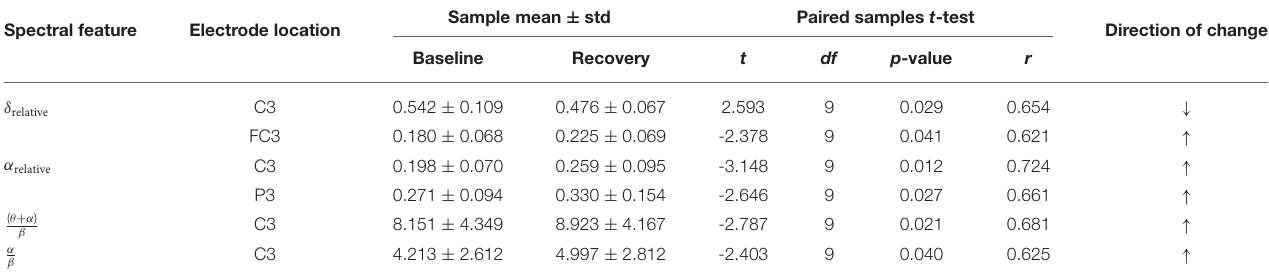
TABLE 2 | Significant EEG spectral feature modulations and the corresponding electrode locations following the gross motor interaction with HapticMASTER. Spectral feature